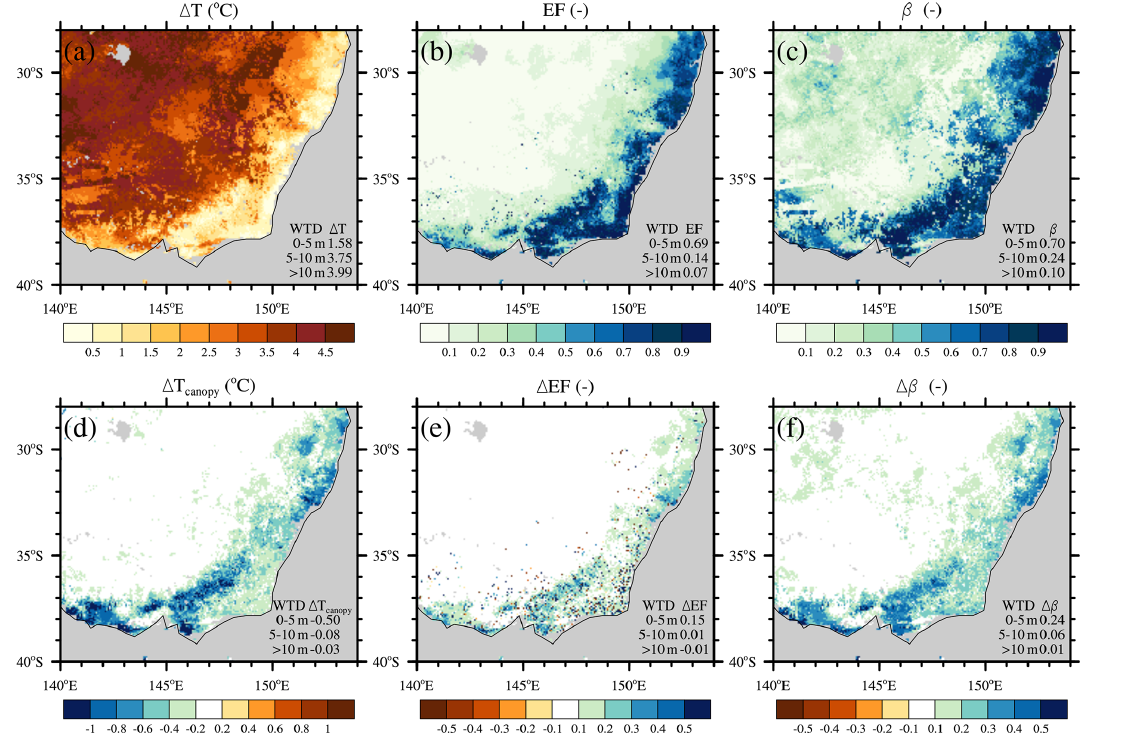
Figure 4. Land response to heatwaves during the recent drought. Panels (a) – (c) are the mean T canopy − T air ( (cid:49)T ), evaporative fraction (EF), and soil water stress factor ( β ) in GW, respectively, during 2017–2019 summer heatwaves. Panels (d) – (f) are the difference (GW–FD) of T canopy , EF, and β . In the bottom right of each plot, the average of each variable over selected water table depths (WTDs) is provided. Note that the colour bar is switched between (d) and (e) – (f) .